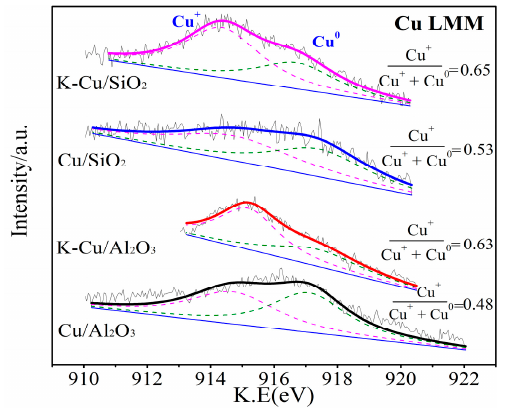
Figure 5. Cu2p 3/2 X-ray photoelectron spectroscopy (XPS) spectra of Cu/Al 2 O 3 , K-Cu/Al 2 O 3 and Cu/SiO 2 , K-Cu/SiO 2 catalysts.